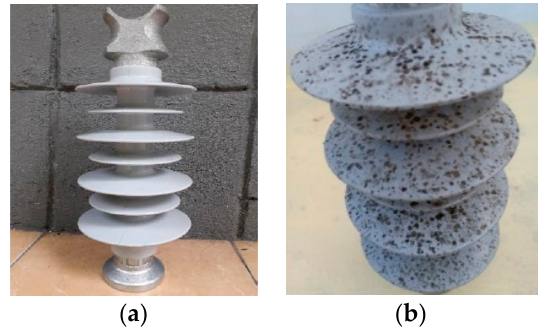
Figure 4. ( a ) Insulator before aging, and ( b ) insulator after